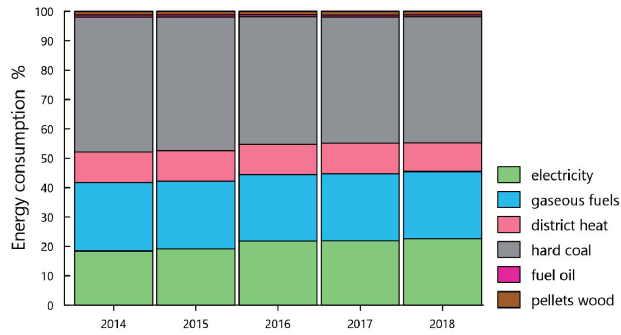
Figure 2. Energy consumption by fuel